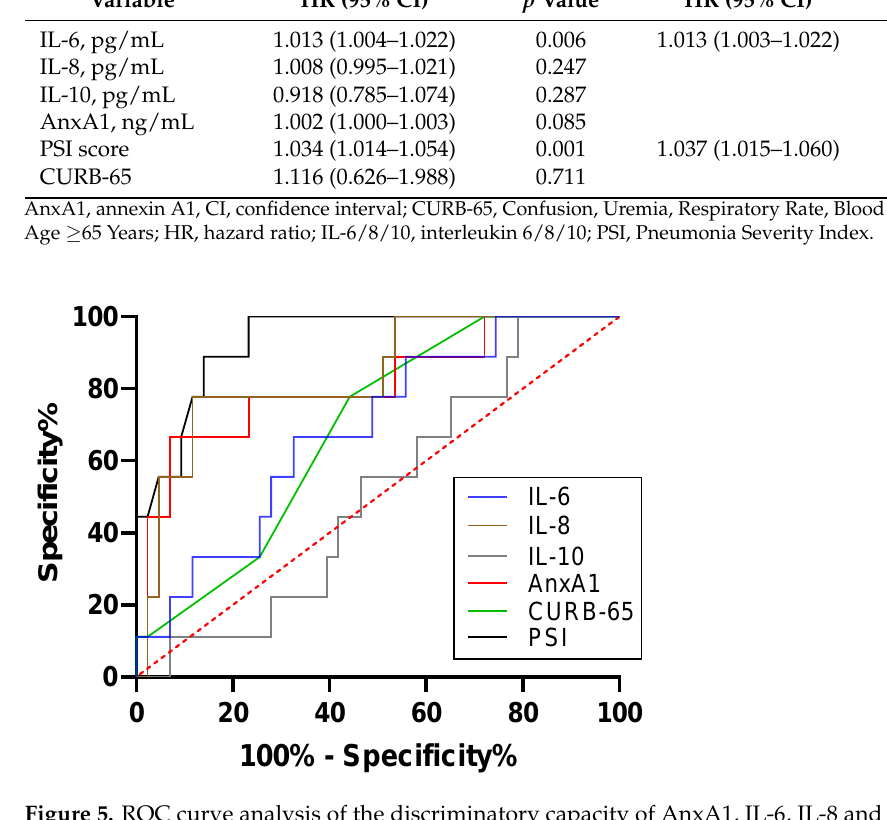
Figure 5. ROC curve analysis of the discriminatory capacity of AnxA1, IL-6, IL-8 and IL-10 levels; PSI and CURb-65 score for predicting 30-day mortality in patients with CAP.